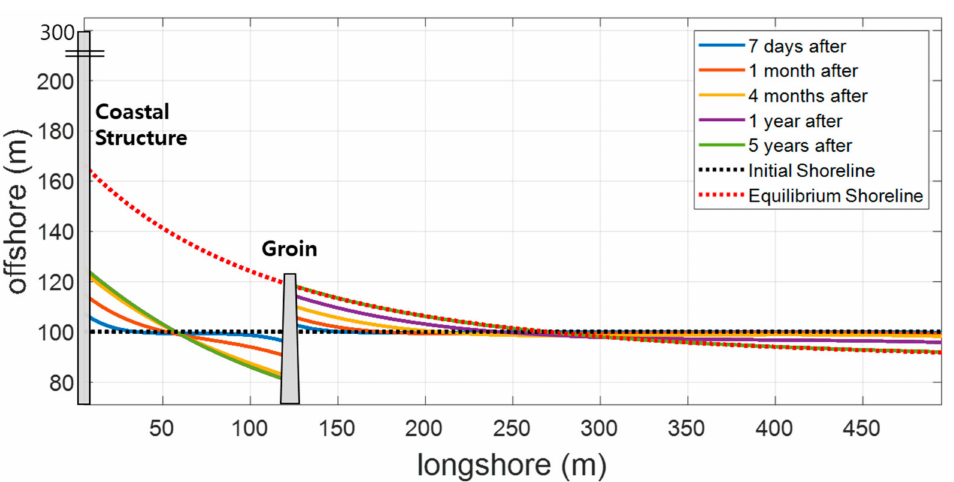
Figure 7. Simulation of shoreline change after construction of